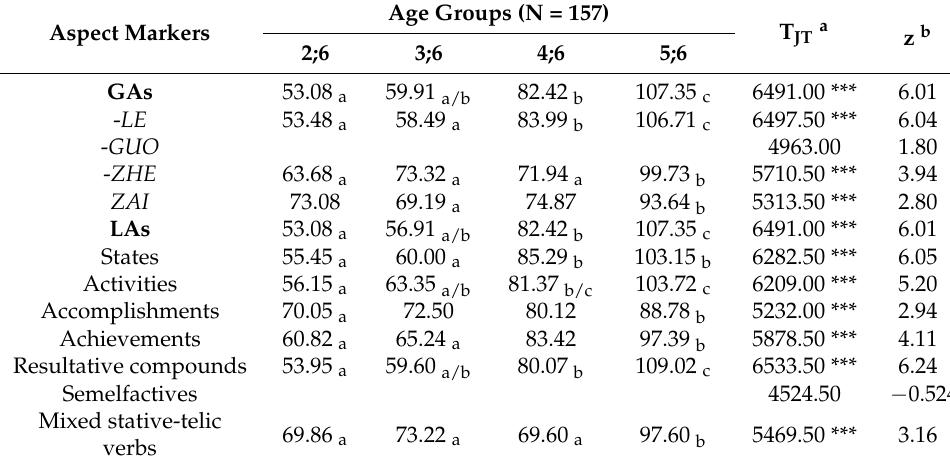
Table 3. Average Ranks of Aspect Marker Production by Children in all age Groups.